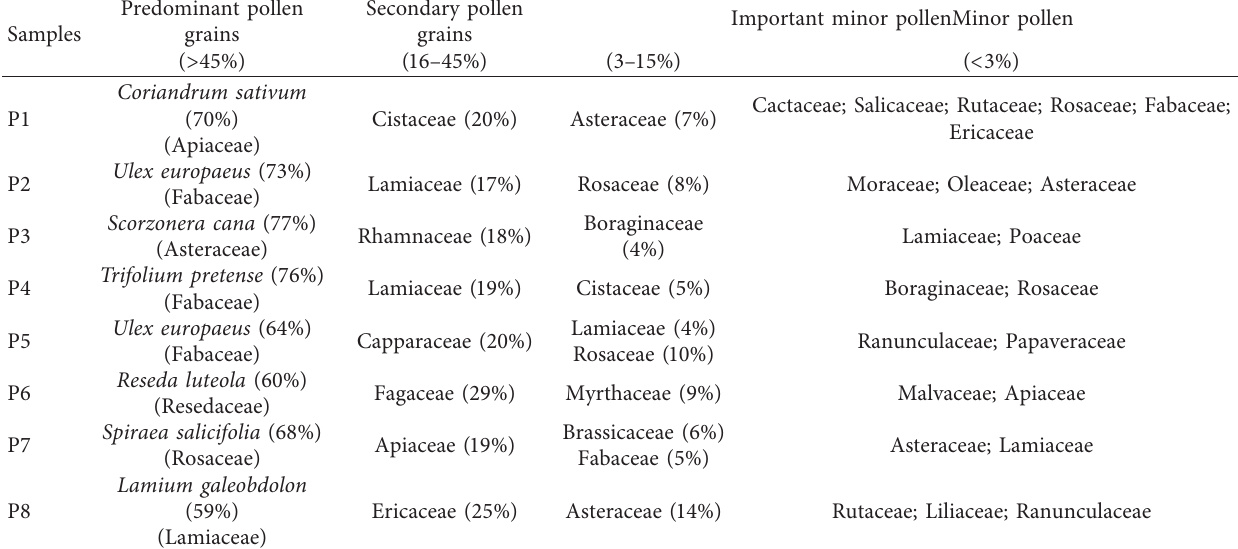
Table 2: Palynological analysis of bee pollen samples.